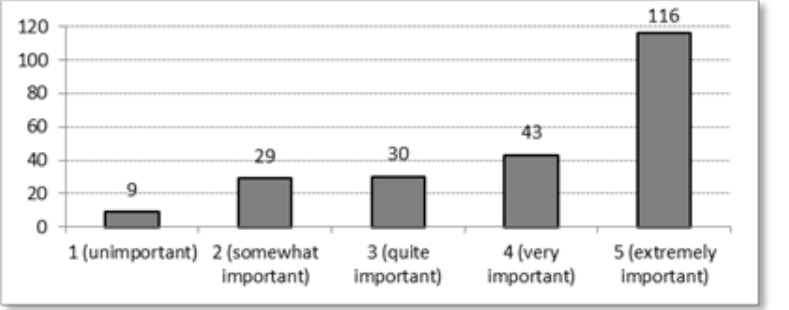
Figure 8. Importance given by deaf and hard of hearing e-learning students to the course programme and quality of content (absolute numbers). Valid answers: 227.